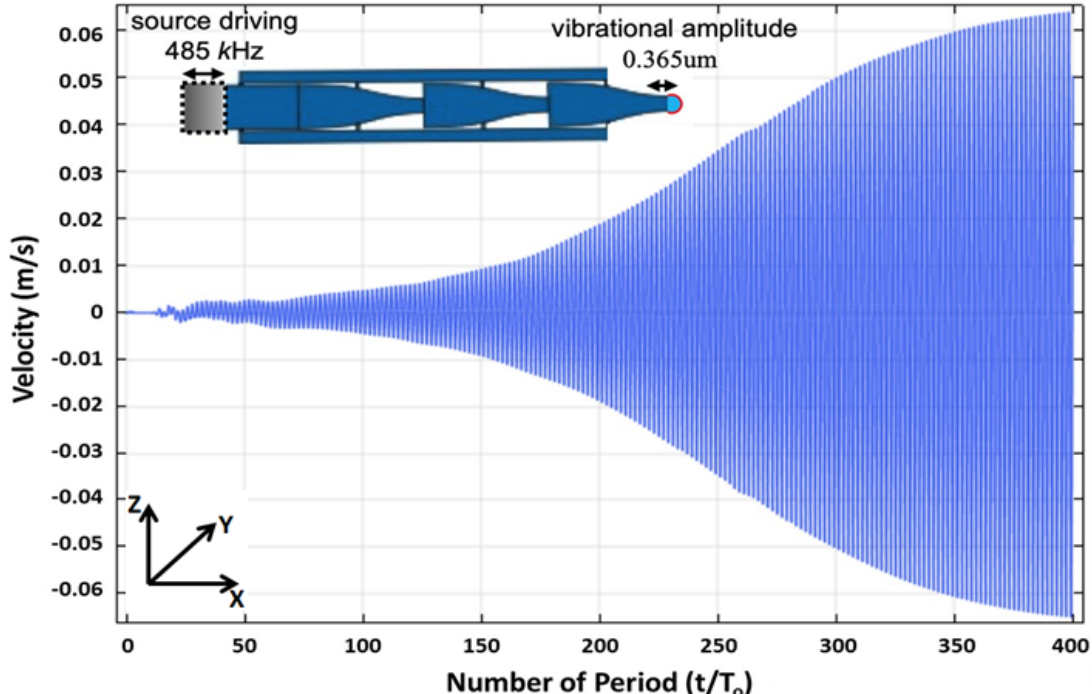
Figure 2. The modeling plot of the velocity in the Z -axis versus time at the nozzle tip of the silicon-based three-horn. In this case, based on the water, we use water parameters of density 𝜌 = 1000 (kg/m 3 ), kinematic viscosity coefficient ν = 1.02 × 10 − 6 (m²/s), and surface tension T = 7.2 × 10 − 2 (N/m). The frequency range was plotted for the perception of harmonic frequency